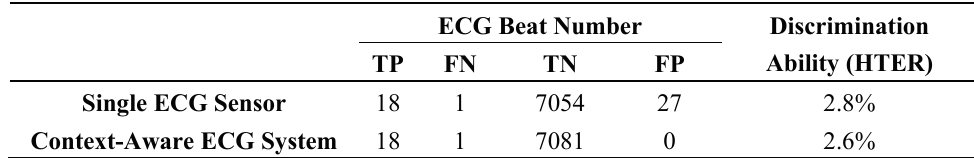
Table 12. Discrimination ability comparison between the proposed context-aware ECG system and single ECG sensor. TP: true positive, FN: false negative, TN: true negative, FP: false